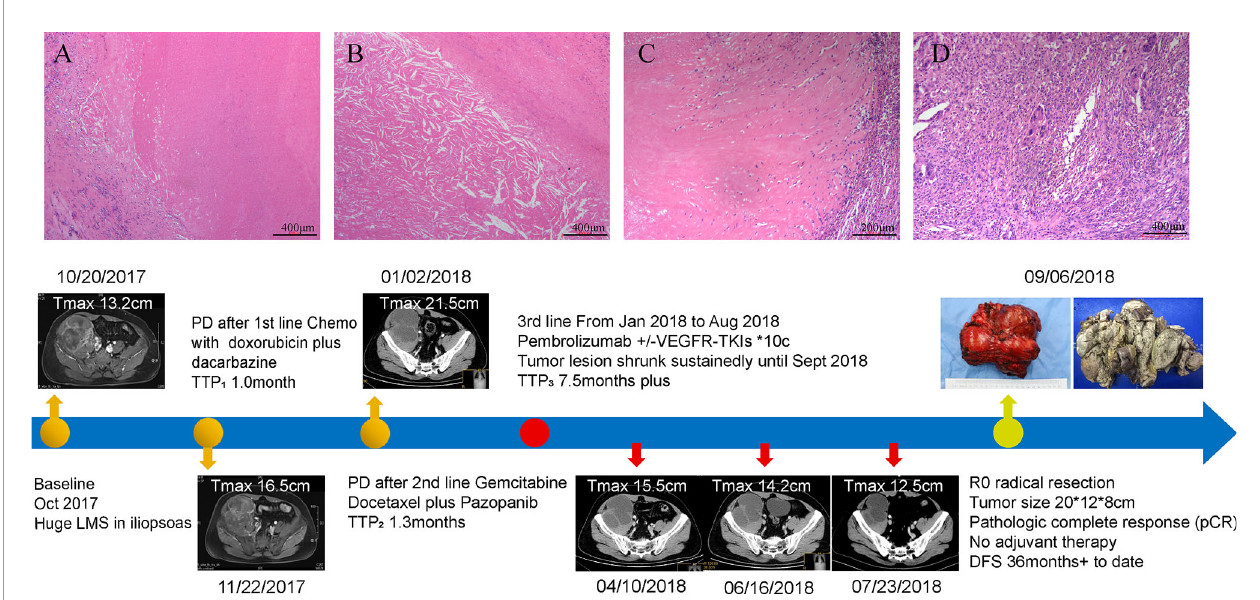
FIGURE 4 | Surgical pathology con fi rmed a pathological complete response (pCR) in this patient and the timeline of interventions and outcomes. (A) A variable extent of coagulative tumoral necrosis. (B) Cholesterol crystals around the tumoral necrosis. (C) Collagen fi bers around the periphery of tumoral necrosis. (D) Histiocytes and multinucleated giant cells in the tumor. The bottom panel shows clinical interventions and outcomes of the patient.